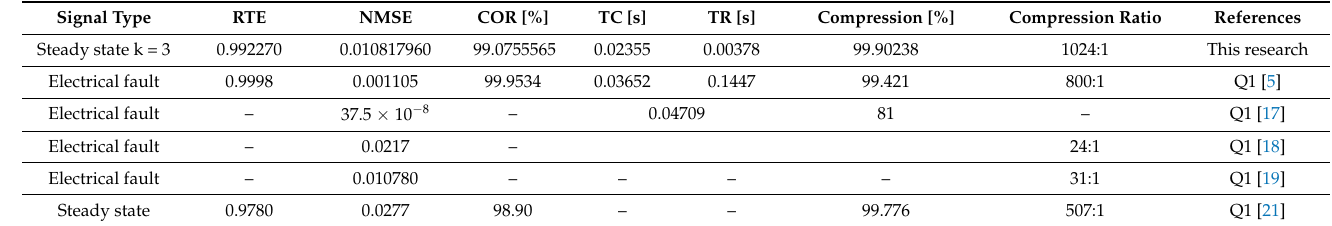
Table 2. Summary of the best results achieved from the most relevant